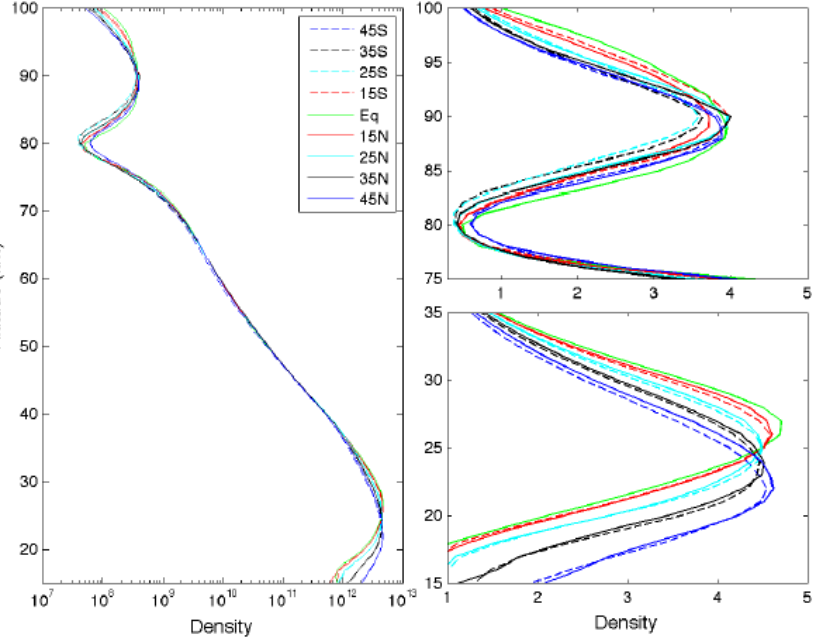
Fig. 26. Average vertical profiles of ozone in the period 2003–2008. The left panel shows vertical profiles at different latitudes (in cm − 3 ). Fig.26. Average vertical profiles of ozone in the period 2003-2008. The left panel shows vertical The upper right panel shows the same profiles in the mesosphere (in 10 8 cm − 3 ) and the lower right panel in the stratosphere (in 10 12 cm − 3 ) profiles at different latitudes (in cm -3 ). The upper right panel shows the same profiles in the (from Kyr¨ol¨a et al., 2010b). mesosphere (in 10 8 cm -3 ) and the lower right panel in the stratosphere (in 10 12 cm -3 ) (from Kyrölä et al., 2010b).